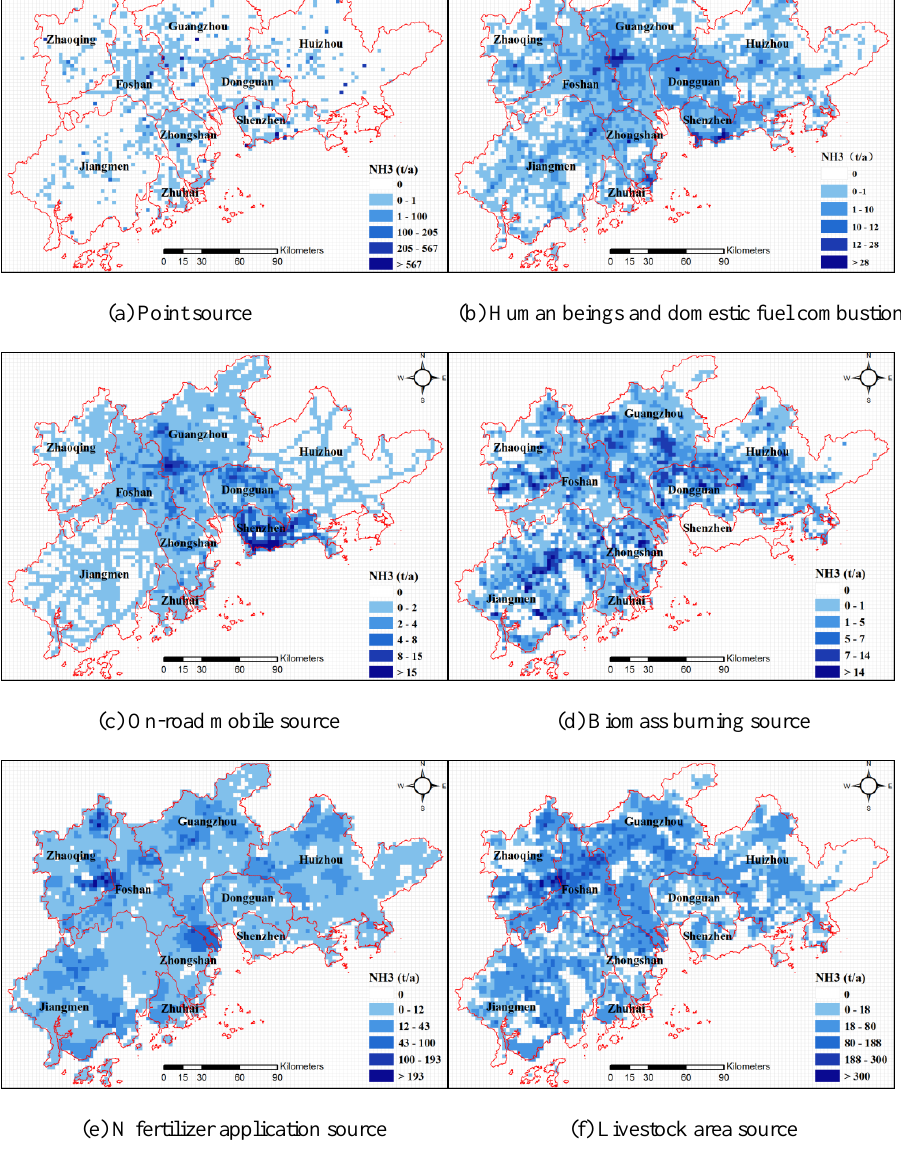
emissions by source category in the PRD region. Fig. 6. Spatial distributions of NH 3